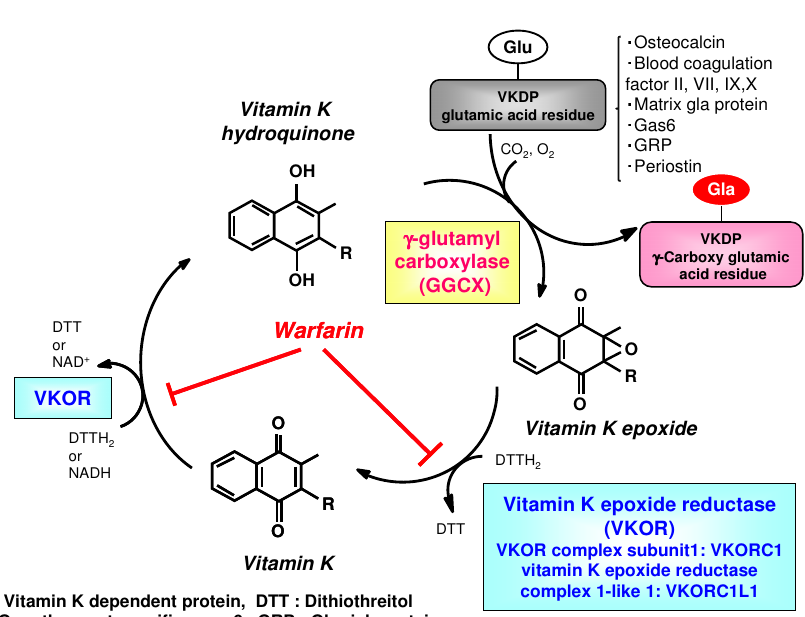
Figure 2. Overview of Vitamin K cycle.